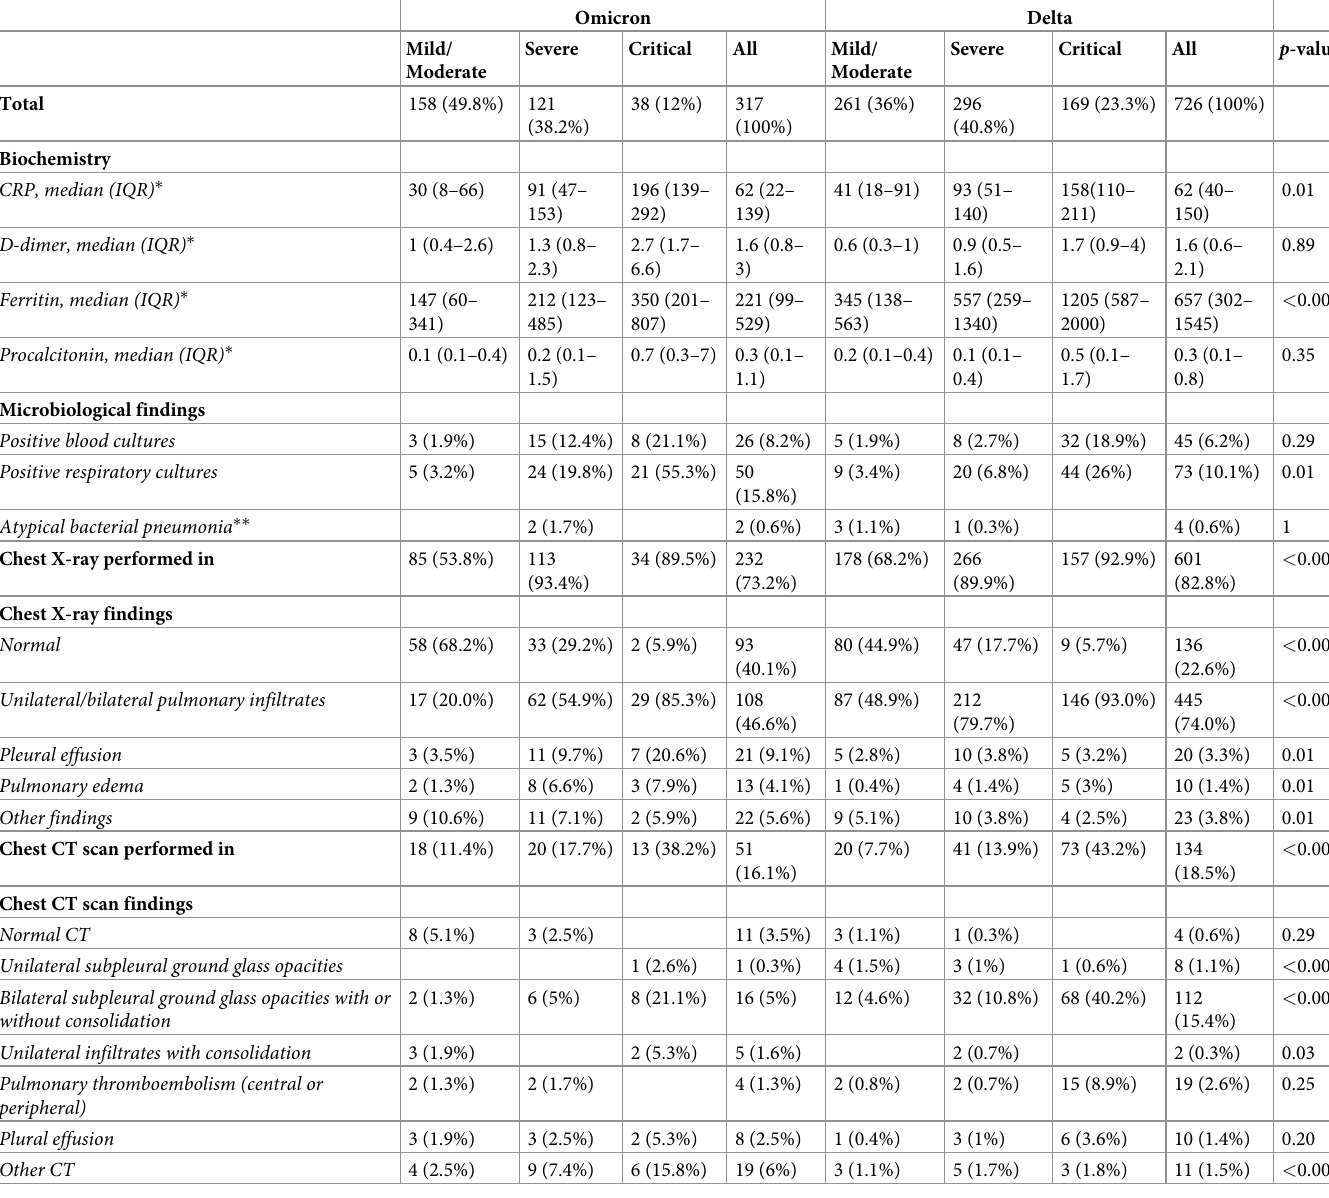
Table 2. Laboratory results of patients hospitalized with COVID-19 due to SARS-CoV-2 Omicron and Delta variants, according to disease severity (Copenhagen, 1 September 2021–11 February 2022; n =